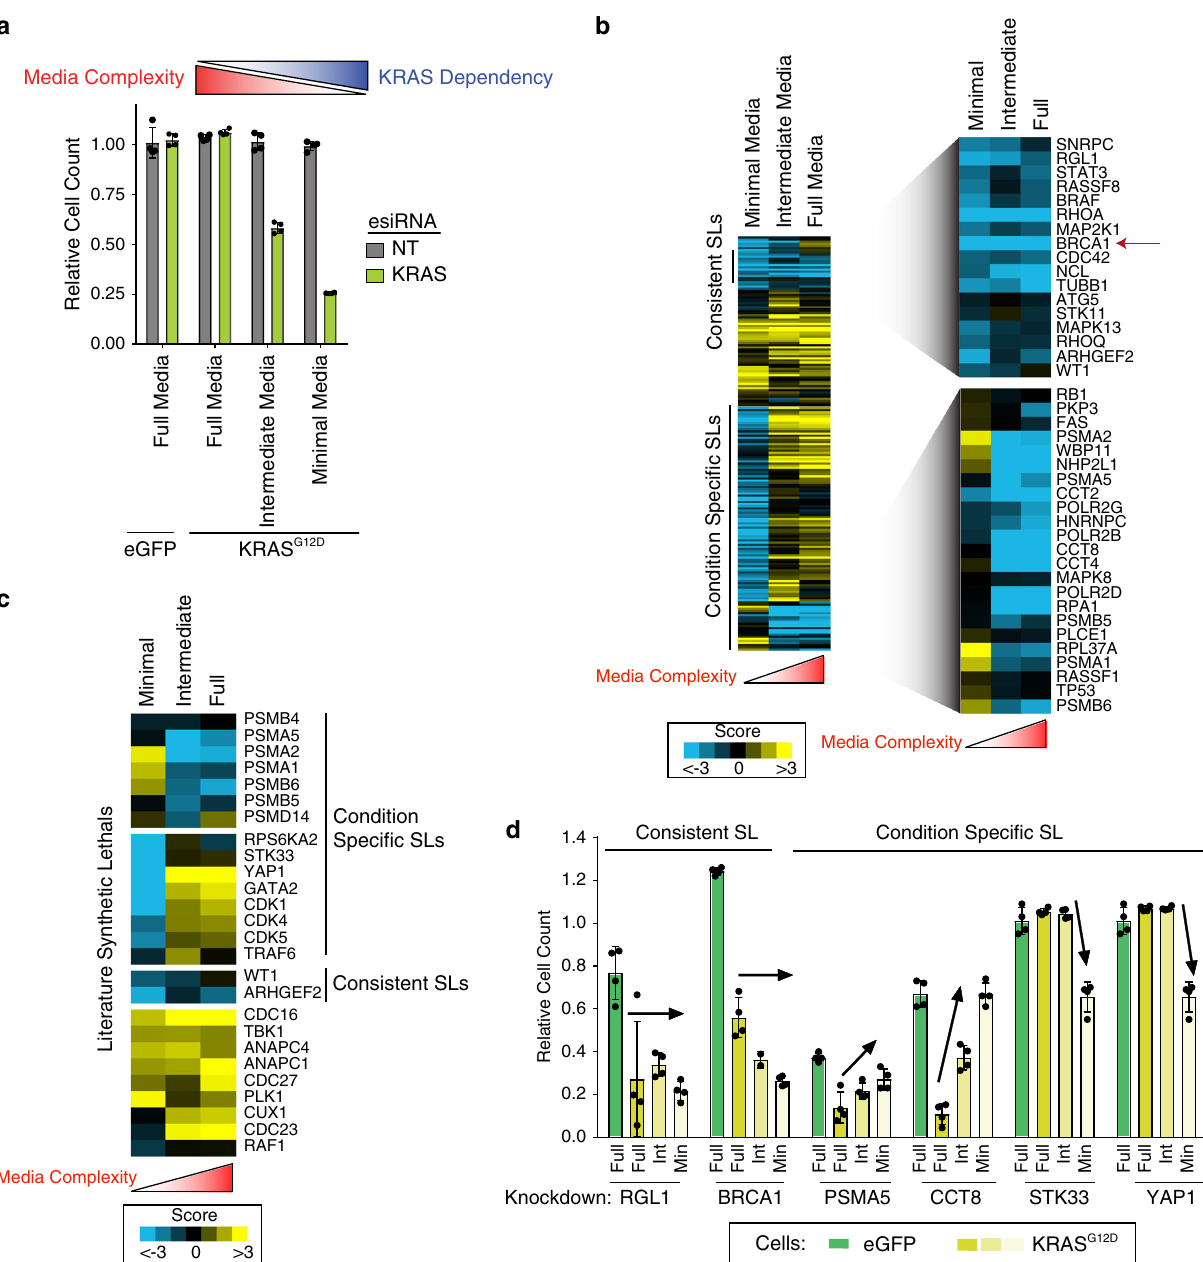
Fig. 5 Dependency on synthetic lethal genes vary based on cellular conditions. a Knockdown of KRAS or non-targeting (NT) in MCF10A eGFP or KRAS G12D cells in the indicated media condition for 72 h. Proliferation measured relative to NT. n = 4 biologically independent samples. Schematic of inverse relationship between media complexity and KRAS dependency shown on top. b Heatmap of genetic interaction scores for KRAS G12D cells grown in full, intermediate or minimal media conditions compared to eGFP cells. Highlighted gene sets show consistent or condition speci fi c synthetic lethality across conditions. Red arrow highlights BRCA1 as a consistent KRAS synthetic lethal. c Heatmap of genetic interaction scores for previously published KRAS synthetic lethals across different growth conditions. d Proliferation of cells grown in the indicated conditions harboring knockdown of indicated genes normalized to NT transfection control. n = 4 biologically independent samples. Full = full media, Int = intermediate media, Min = minimal media. Data are presented as mean values ±